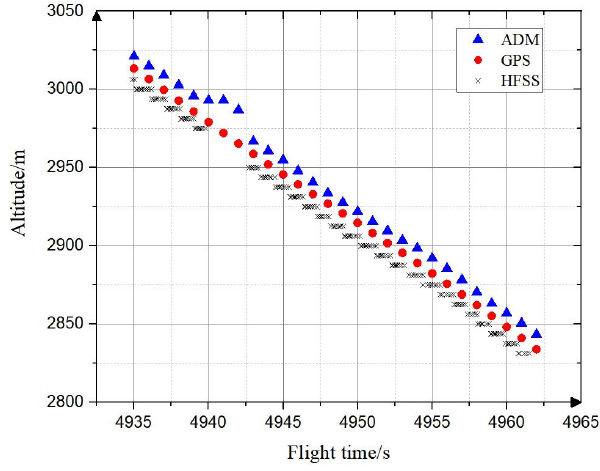
Figure 5. Altitude measured by HFSS range-compressed data (the black cross), ADM altitude (the blue triangle), and the reference height provided by GPS (the red dot) at the same period.